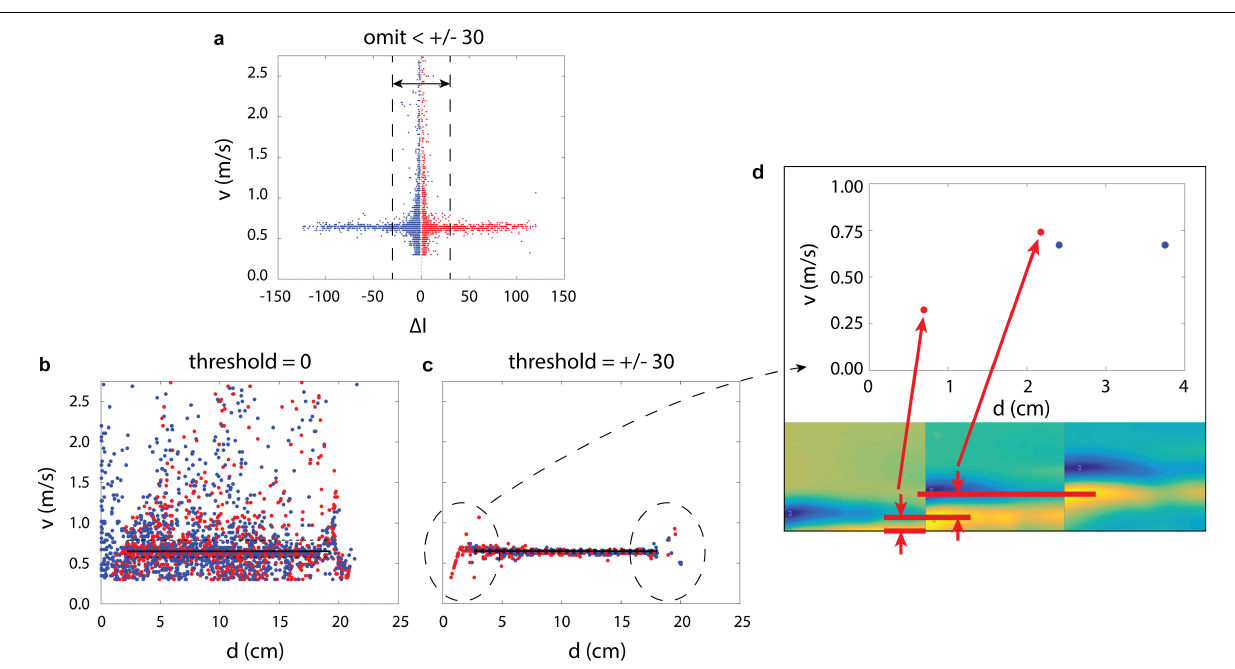
FIGURE 4 | (a) Velocity measurements shown against the difference in light magnitude, (cid:49) I, for experiment Ex7. Blue and red dots respectively represent negative and positive values. The measurements are more consistent at large magnitudes (both positive and negative). (b) With no threshold set, the velocity measurements are scattered. (c) Measurements within the magnitude of ± 30, shown by the vertical dashed lines in subplot (a) , are thrown out. Boundary artifacts remain in the measurements and are circled. (d) The artifacts appear when a wave enters or leaves the field of view. The red dots here correspond to the velocity of the yellow region and its velocity entering the frame is